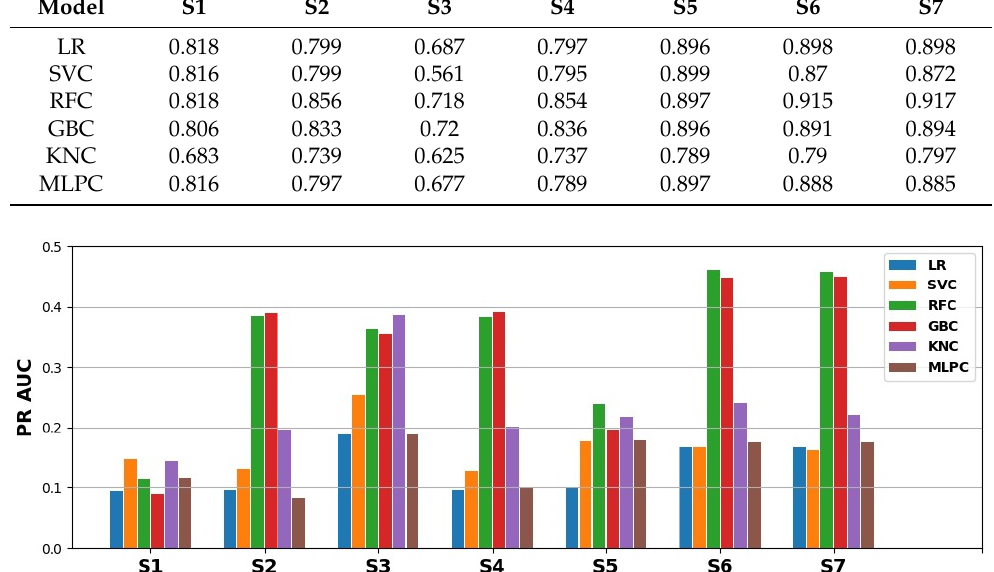
Figure 6. PR AUC values for particular algorithms and attribute subsets.